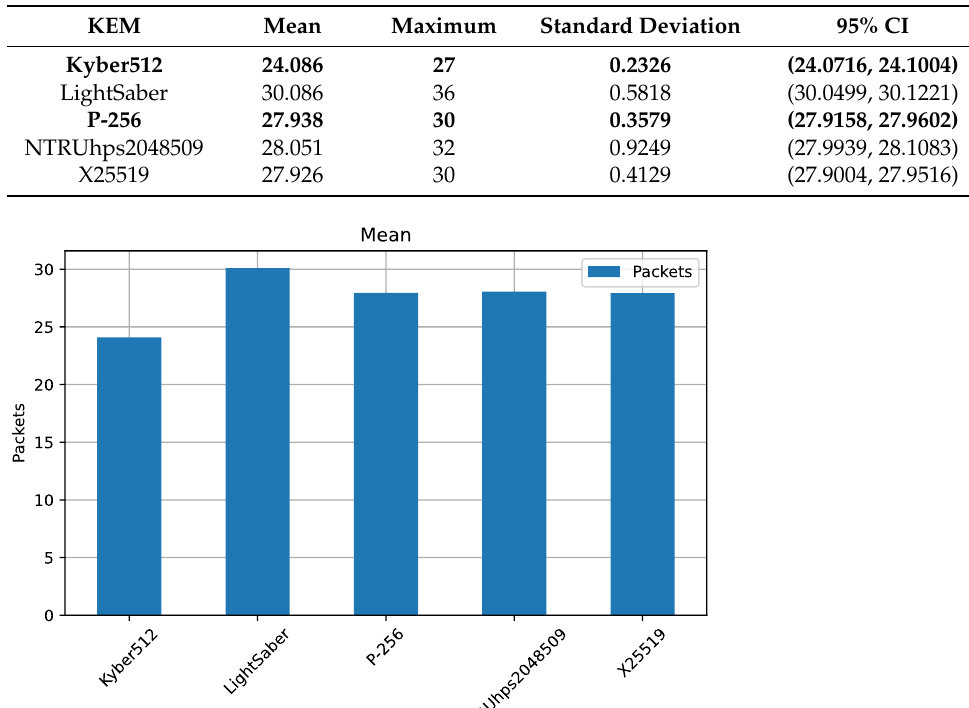
Table 8. Number of packets transmitted during the connection. The best-performing is Kyber512,